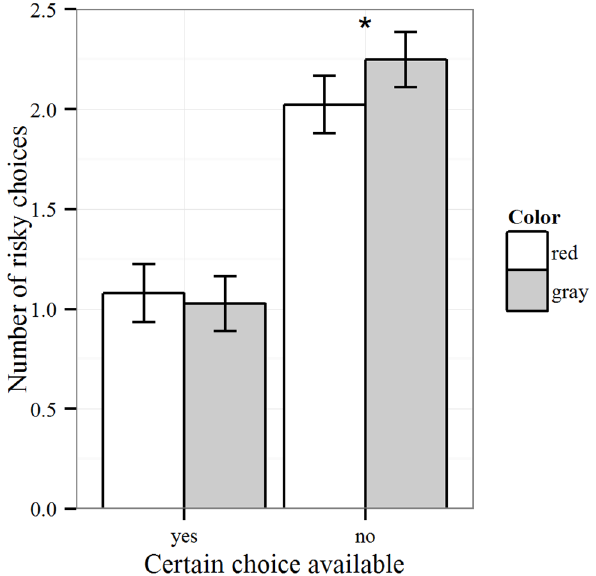
Fig 1. Number of risky choices by color manipulation and risk option (with 95% confidence